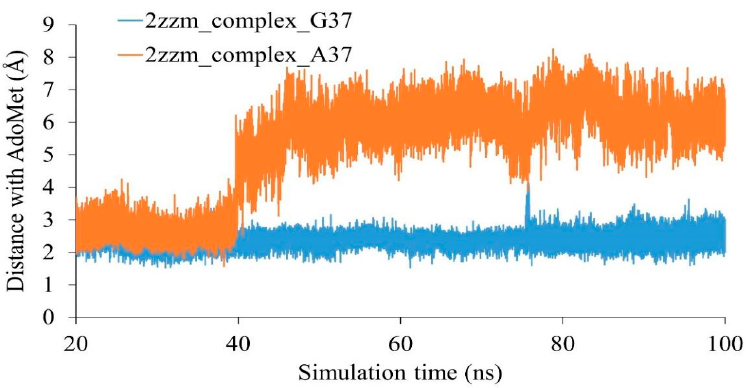
Figure 4. Distance between the 37th nucleotide of tRNA and S-adenosyl methionine in wild-type (2zzm_complex_G37) and mutant tRNA (G37A) complex (2zzm_complex_A37).